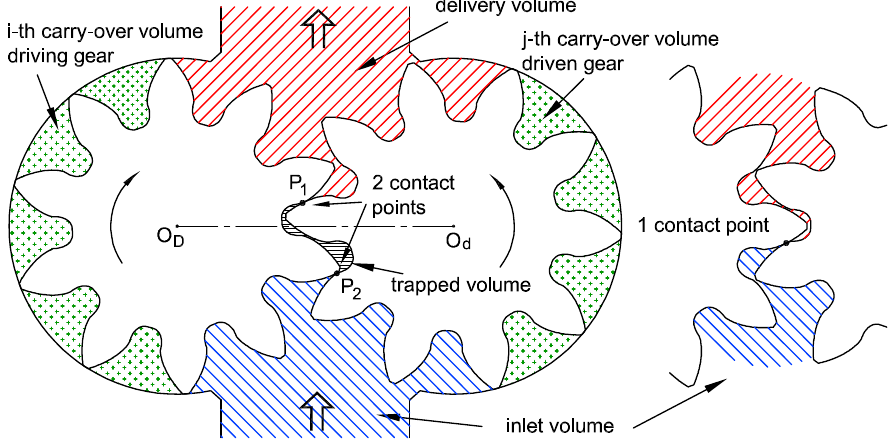
Figure 4. Definition of the control volumes in an external gear pump with the MC method.